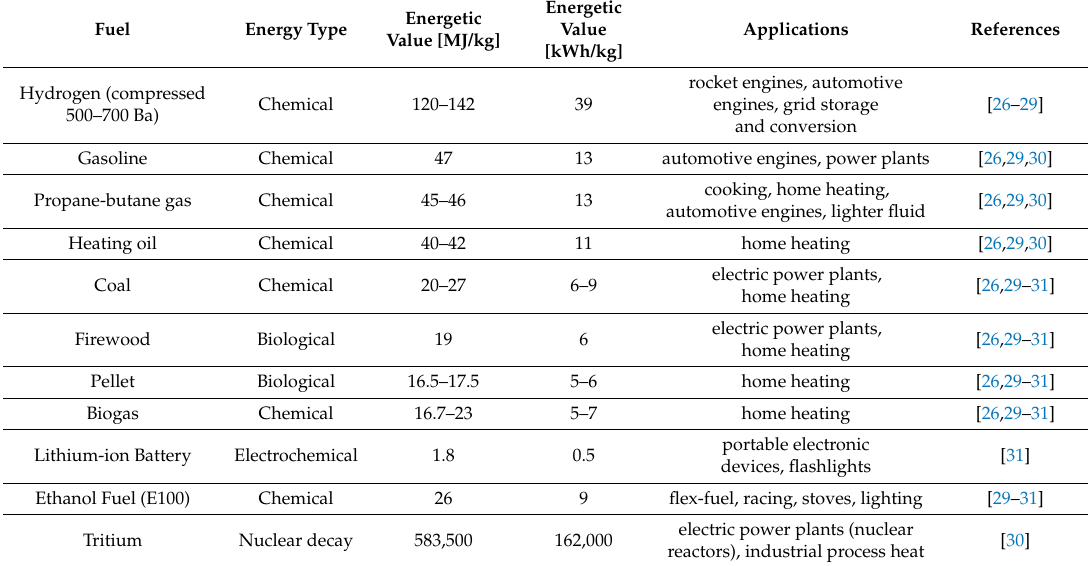
Table 1. Energetic potential of selected